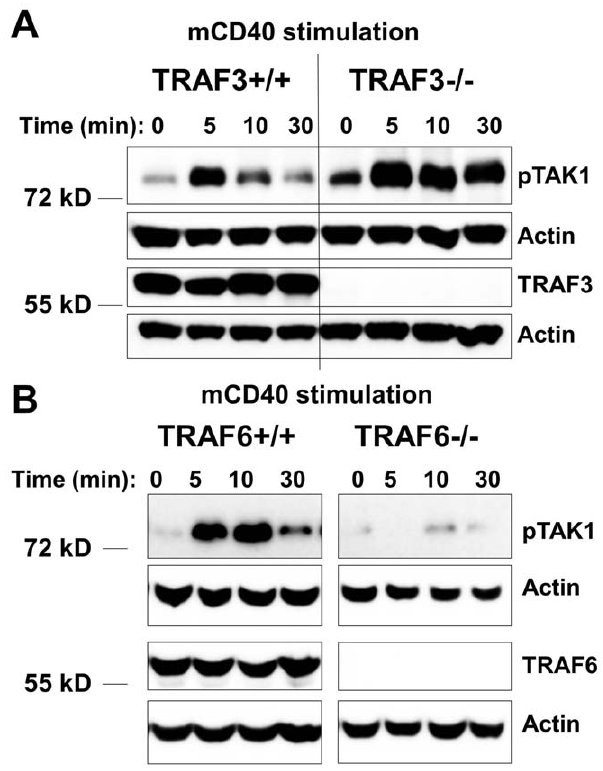
Figure 5. Requirement of TRAFs in CD40-mediated TAK1 activation. A) A20.TRAF3 + / + or A20.TRAF3 2 / 2 mouse B cells were stimulated with anti-mCD40 Ab for 0, 5, 10, or 30 min. Western blots show pTAK1 and TRAF3, with actin as a loading control. B) Similar to panel A , except that A20.TRAF6 + / + or A20.TRAF6 2 / 2 mouse B cells were used. Western blots show pTAK1 and TRAF6, with actin as a loading control. These images were part of the same membrane, but the middle lanes were omitted here for clarity. Data shown are representative of at least four independent experiments.